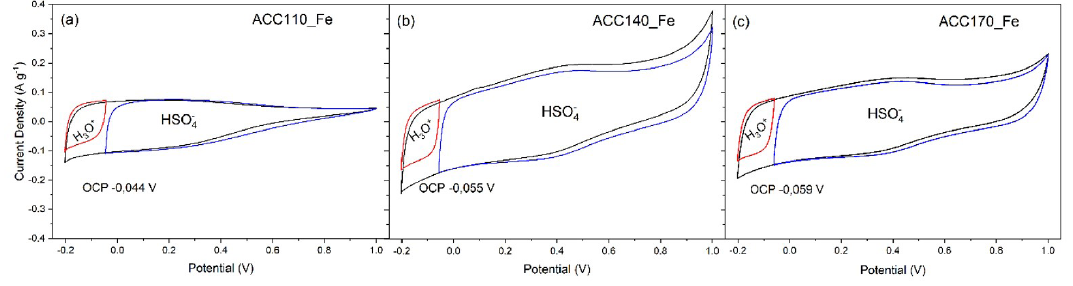
Figure 9. Cyclic voltammetry of samples (a) ACC110_Fe, (b) ACC140_Fe, and (c) ACC170_Fe in aqueous solution H